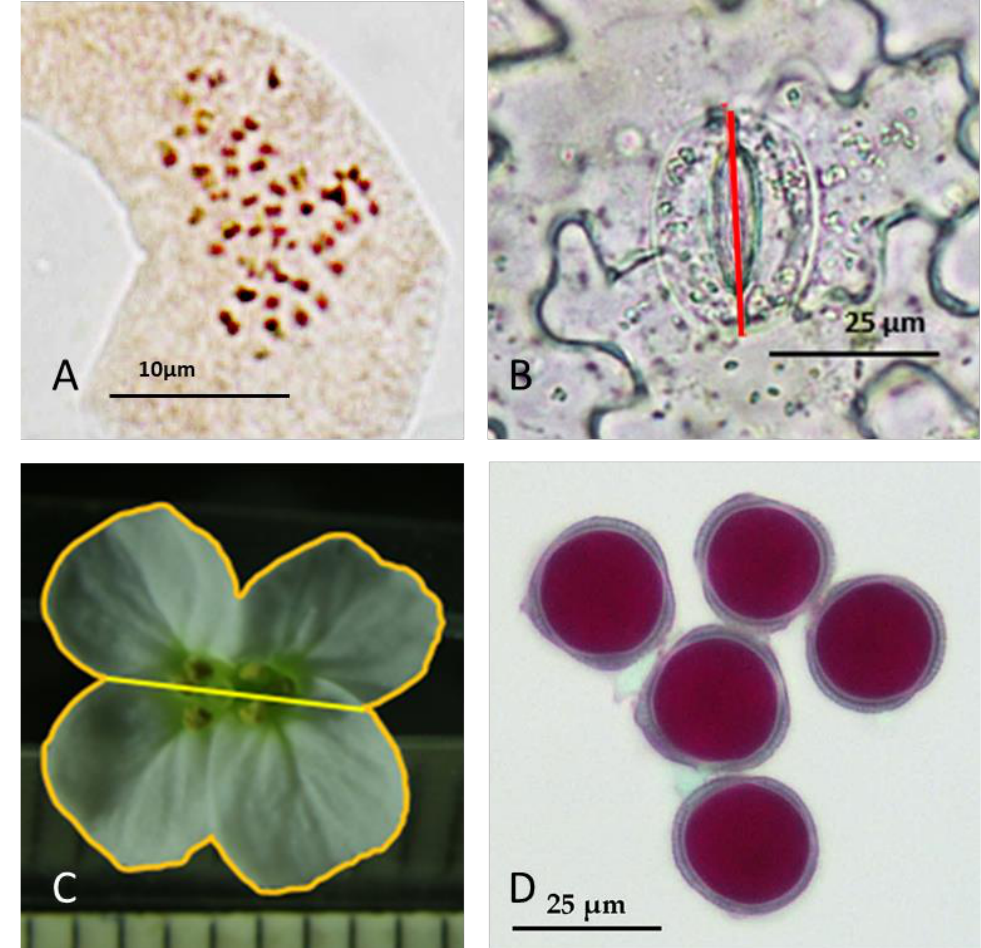
Figure 4. Morpho-anatomical characters of octaploid regenerants of Arabidopsis arenosa and chromo- some number of their progeny. Metaphase plate 2 n ≈ 64 ( A ), stomata length (marked with a red line) ( B ), flower width (marked with a yellow line) and area (marked with an orange line) ( C ), viable pollen grains stained with Alexander dye ( D ). The added lines illustrate how stomata and flowers were measured.